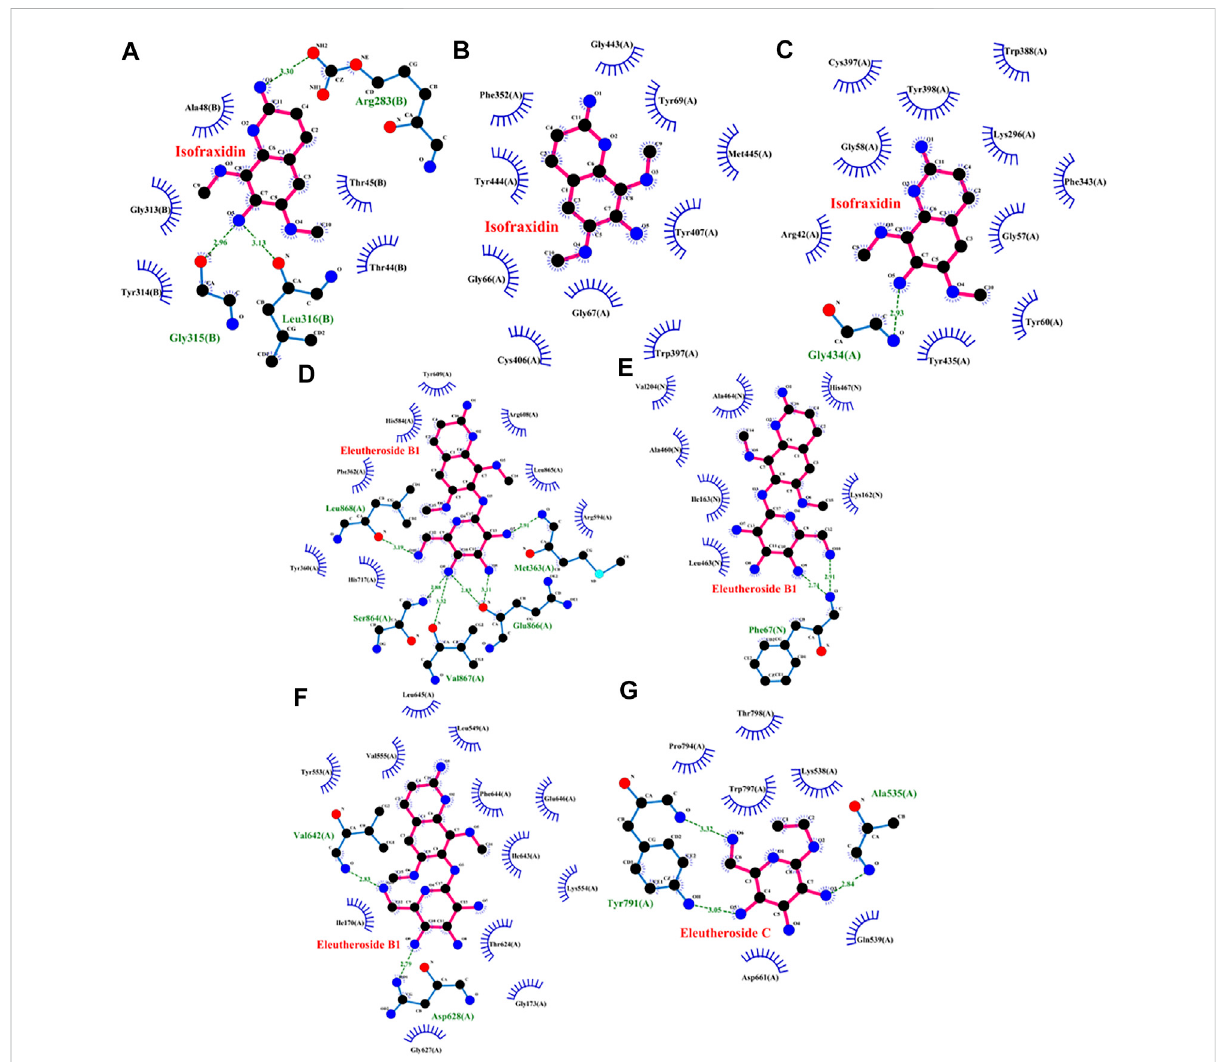
FIGURE 9 Molecular docking charts of isofraxidin [DAO (A) , MAOA (B), and MAOB (C) ], eleutheroside B1 [GAA (D) , HK1 (E) , and PYGM (F) ], and eleutheroside C [PYGM (G) ].